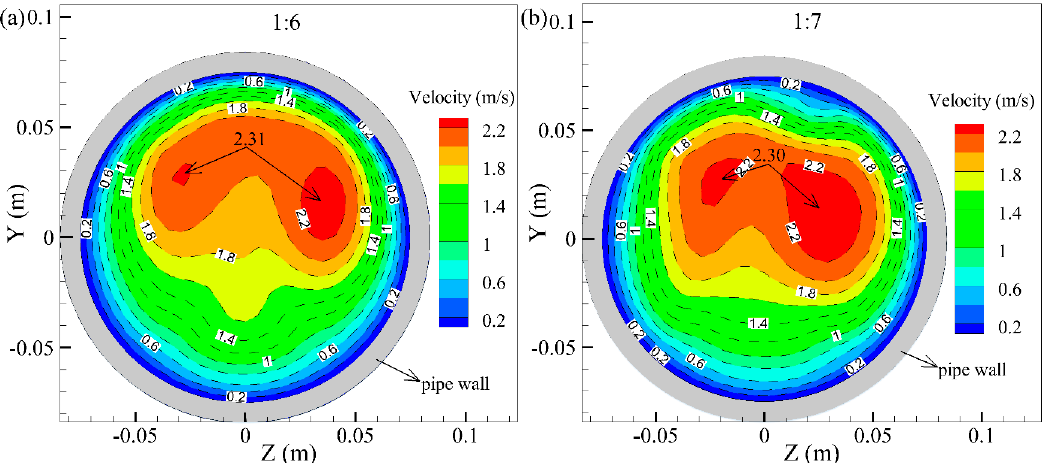
Figure 9. Velocity contours at the outlet for different leaching residue:classified tailings mass ratios: ( a ) 1:6 and ( b ) 1:7.